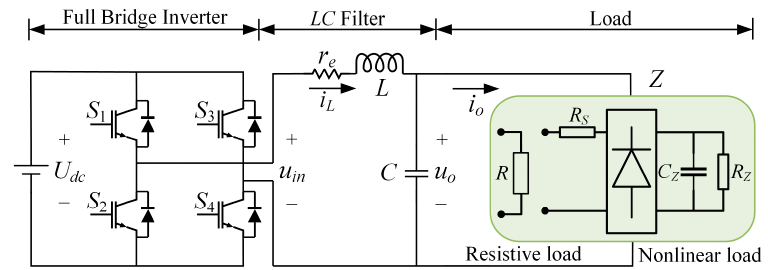
Figure 1. Single-phase inverter with LC filter.